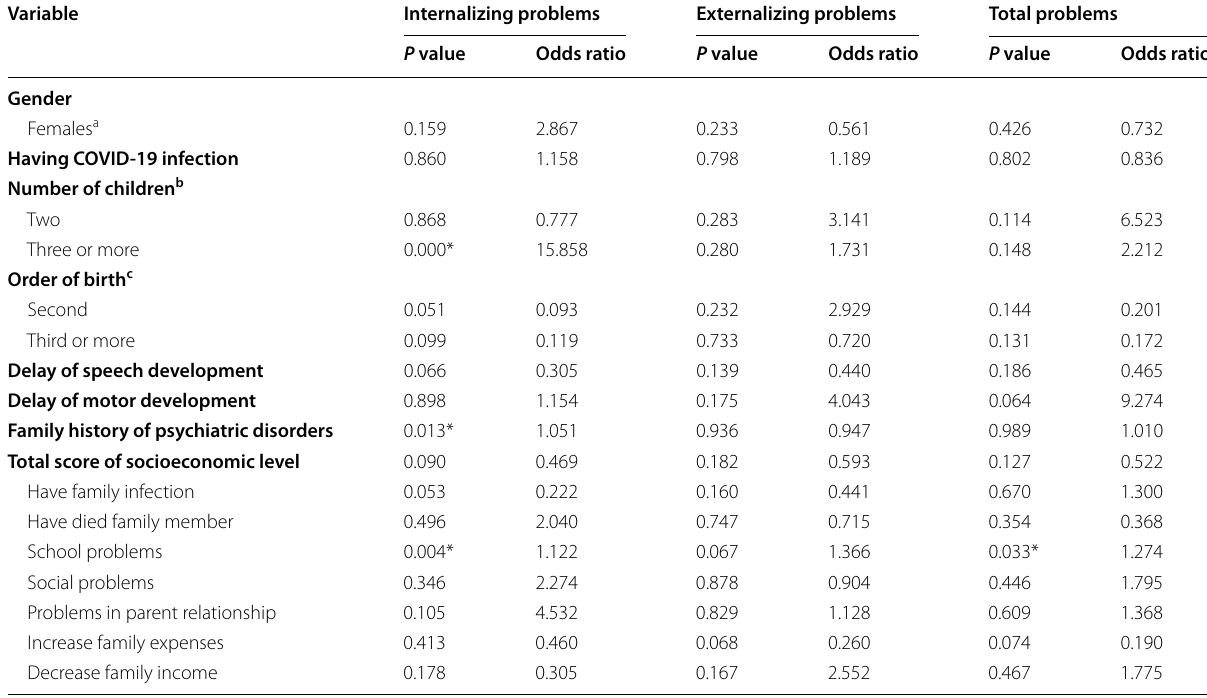
Table 5 Multivariate logistic regressions analysis of risk factors for internalizing, externalizing, and total problems in